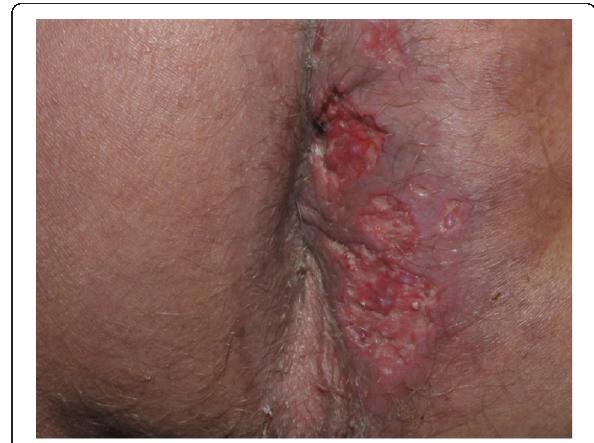
Figure 1 Cutaneous tuberculosis: fagedenic perianal ulcer.